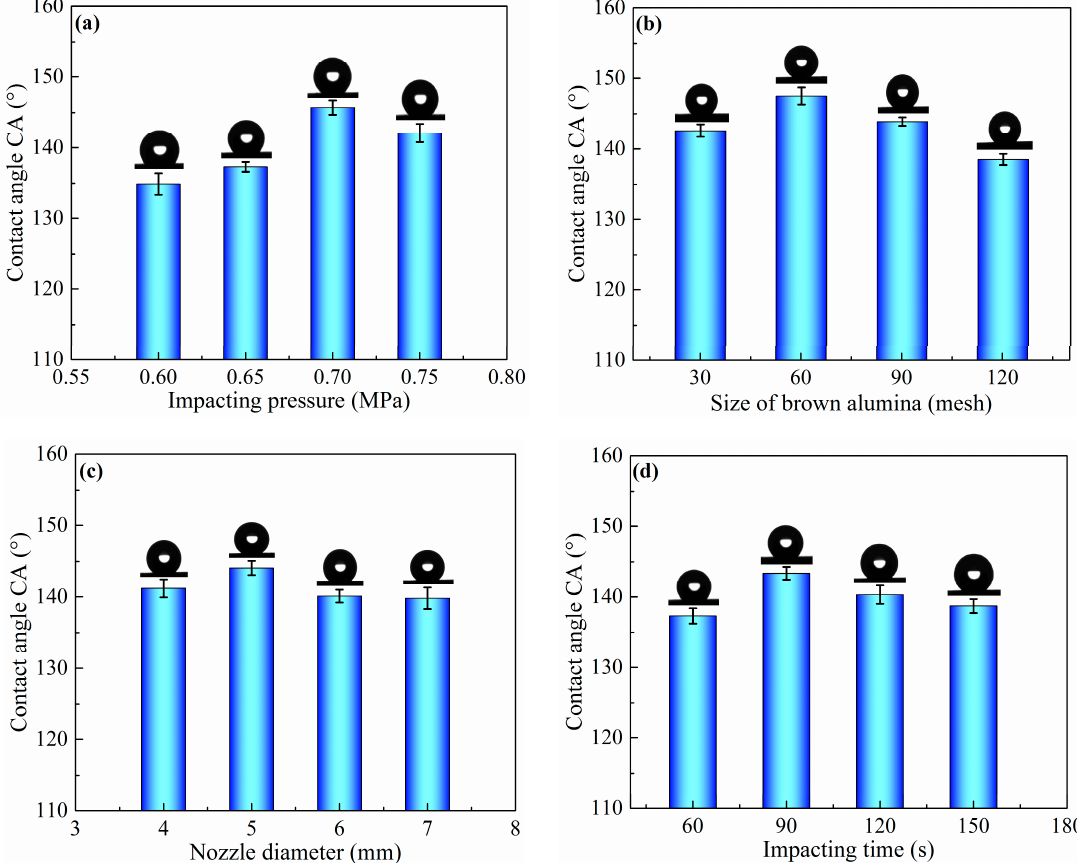
Figure 1. Contact angle (CA) of sample surfaces obtained by sand peening using different process parameters, such as ( a ) impacting pressure, ( b ) size of brown alumina, ( c ) nozzle diameter, and ( d ) impacting time.